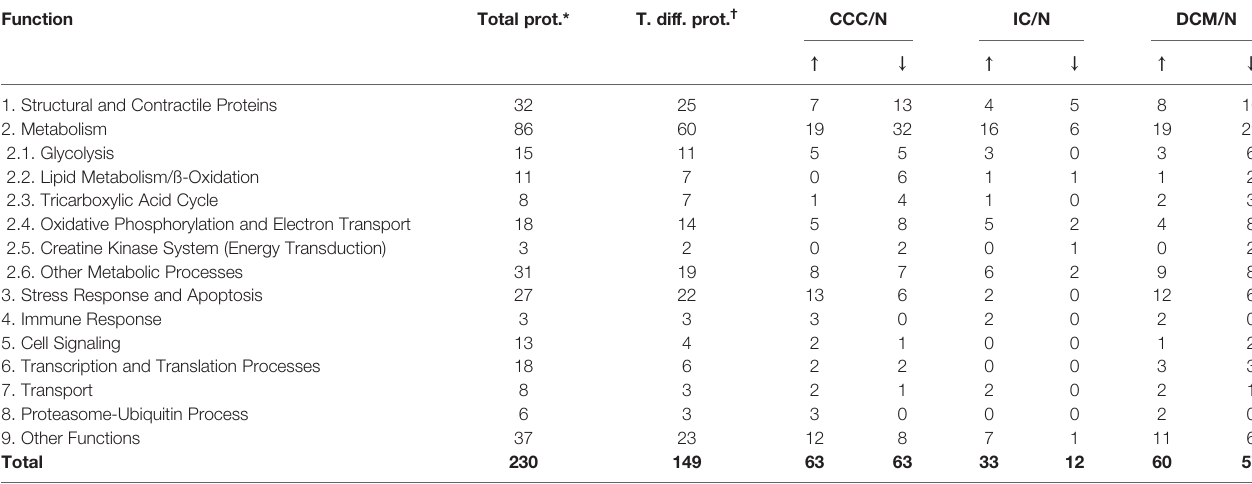
TABLE 3 | Functional classi fi cation of the proteins differentially expressed in the myocardium from patients with CCC, IC and DCM. Function Total prot.* T. diff. prot. †